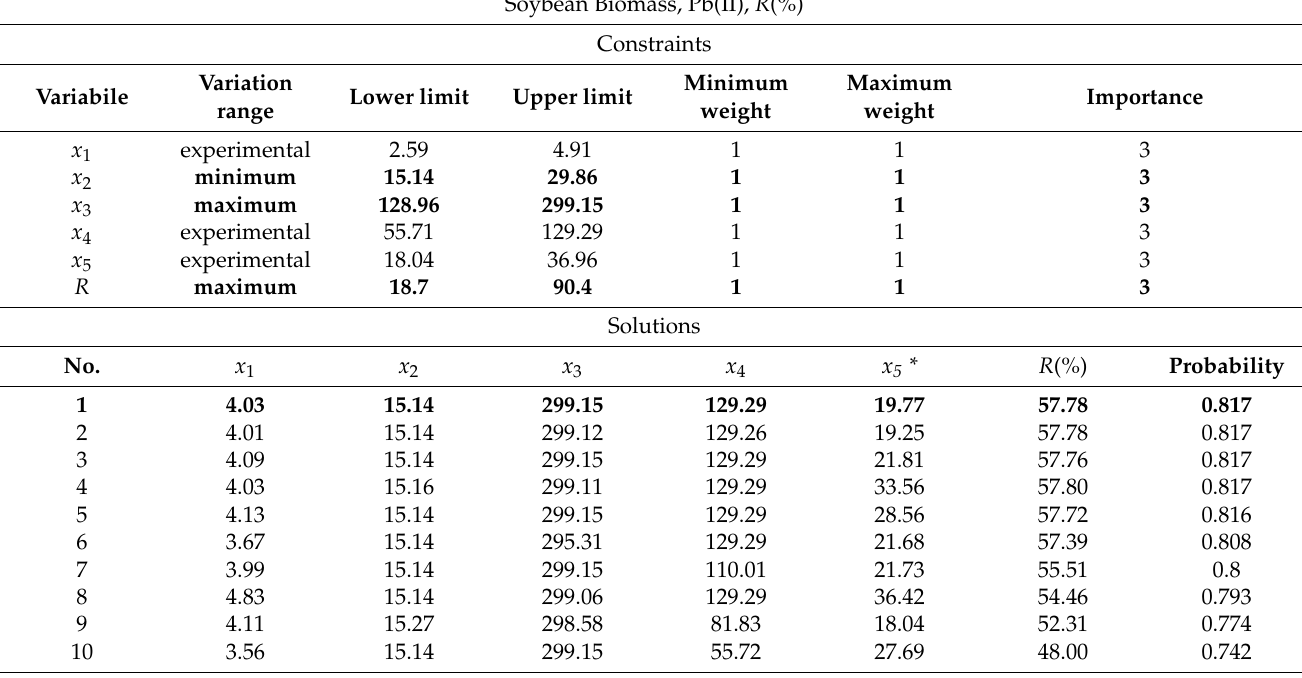
Table 12. Solutions for the operation in favorable conditions for reaching the maximum value of the biosorption efficiency ( R , %) of soybean biomass and soybean waste biomass considering a series of constraints (minimum dose of sorbent and maximum concentration of metal ion in